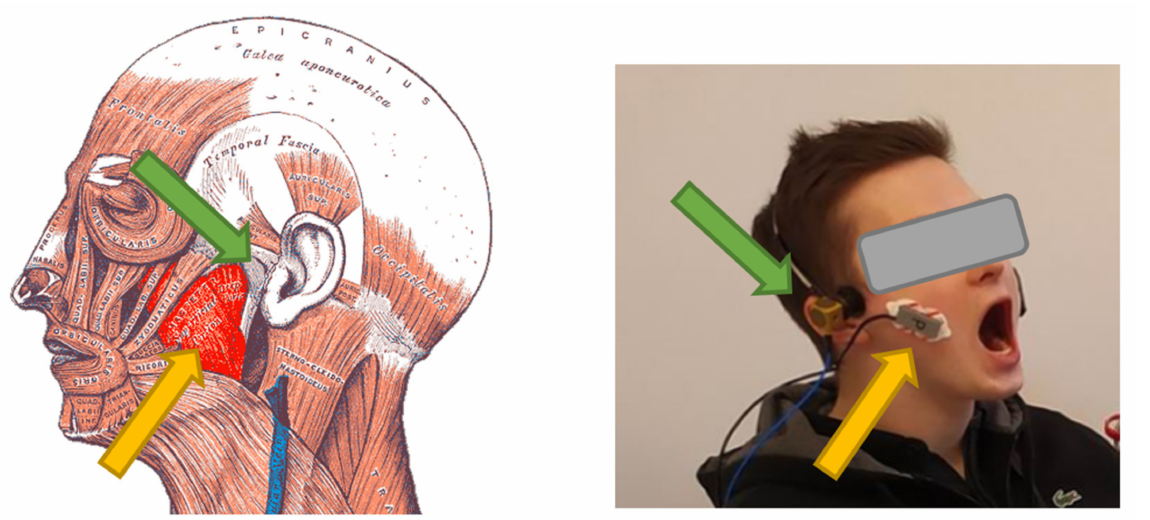
Figure 3. Examination of the patient with TMD. Indication of EMG electrode mounting location (yellow arrow) and acceleration sensor mounting location (green arrow). (Anatomical image from Wikipedia under public domain